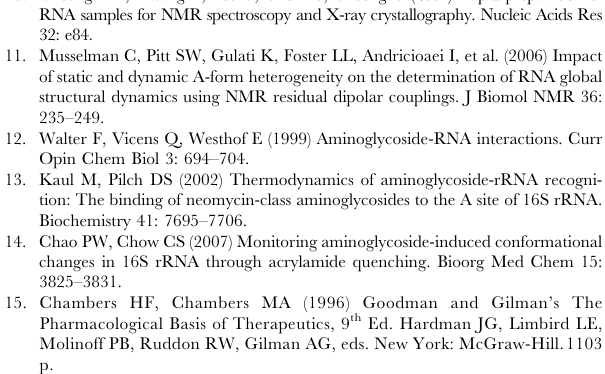
Figure S1 The slope of the plot of log K versus log [Na + ] on the binding of ADG (- N -) and DAU (- & -) to tRNA. (TIF) Figure S2 Partitioned polyelectrolytic ( D G pe ) (shaded) and nonpolyelectrolytic ( D G t , black) contributions to the Gibbs energy of the complexation of ADG (A) and DAU (B) at different [Na + ] concentrations.